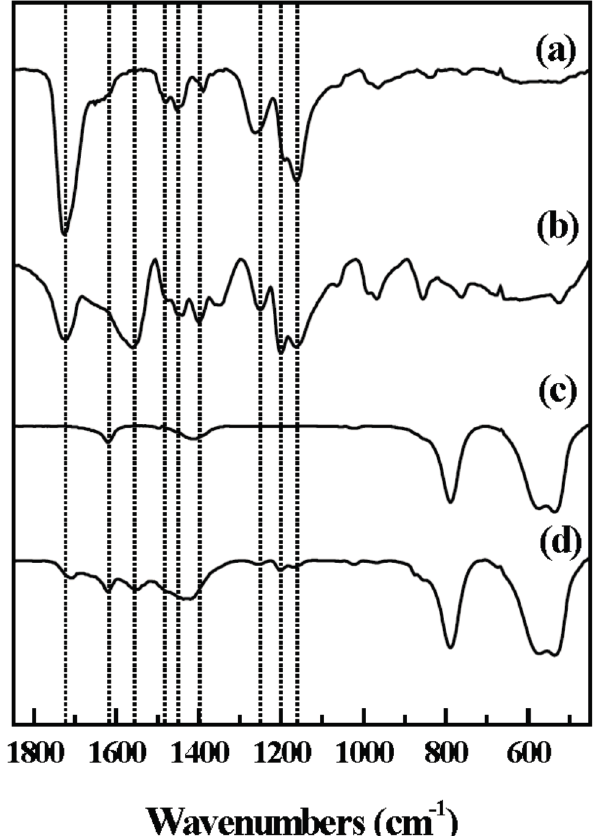
Figure 2. FT-IR spectra of (a) Eudragit ® L 100 (b) Na + -Eudragit ® L 100 salt (c) pristine CaAl-LDH and (d) E-coated CaAl-LDH. The dotted lines are positioned and 1727, 1625, 1556, 1482, 1448, 1392, 1252, 1195, and 1166 cm − 1 ,